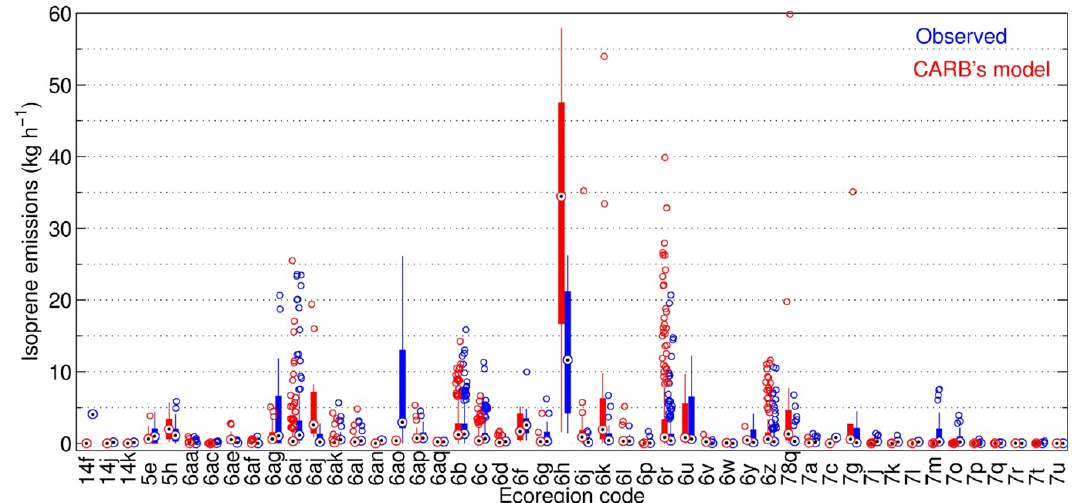
Figure 7. Box plots showing distribution of emissions in each of the level IV ecoregions. The boxes correspond to midrange (25th to 75th percentiles), the whiskers indicate variability outside the lower and upper quartiles, and the circles denote outlying emission hotspots.